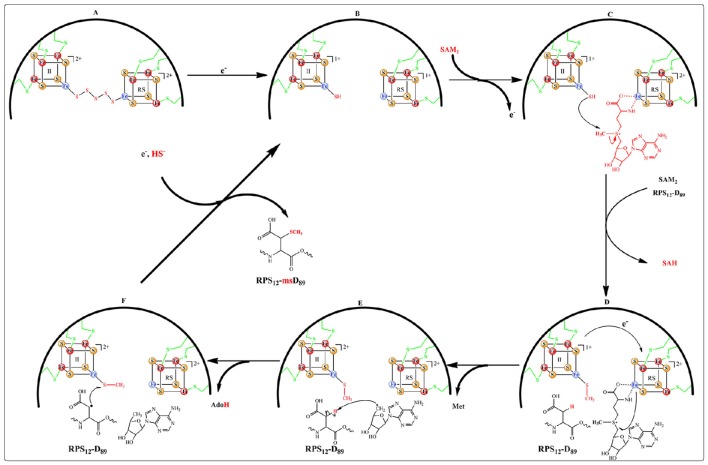
Proposed catalytic mechanism for RPS12-msD89 biosynthesis catalyzed by RimO.